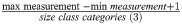
Genetic and reproductive traits in Acropora hyacinthus from the Western Pacific Region.The evolutionary history was inferred based on 767 bp of the putative mitochondrial control region (mtCR) of Acropora hyacinthus using the maximum likelihood method based on the H-K-Y model and 1000 bootstrap replications. The bootstrap support value is shown next to the branches, and 3 groups were found. Acropora hyacinthus (acc. Number KF448531) was included, and Isopora cuneata (acc. number AY026429) was used as an outgroup. Next to each sample location, colored squares indicate the calculated size class—small (black), medium (green) and large (red)—for the locations of main reproductive traits using the formula: maxmeasurement-minmeasurement+1sizeclasscategories(3).